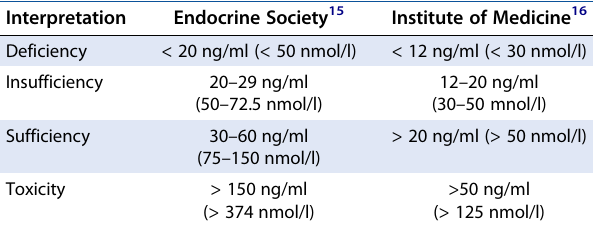
Table 1: Interpretation of serum 25-hydroxyvitamin D (25(OH)D)